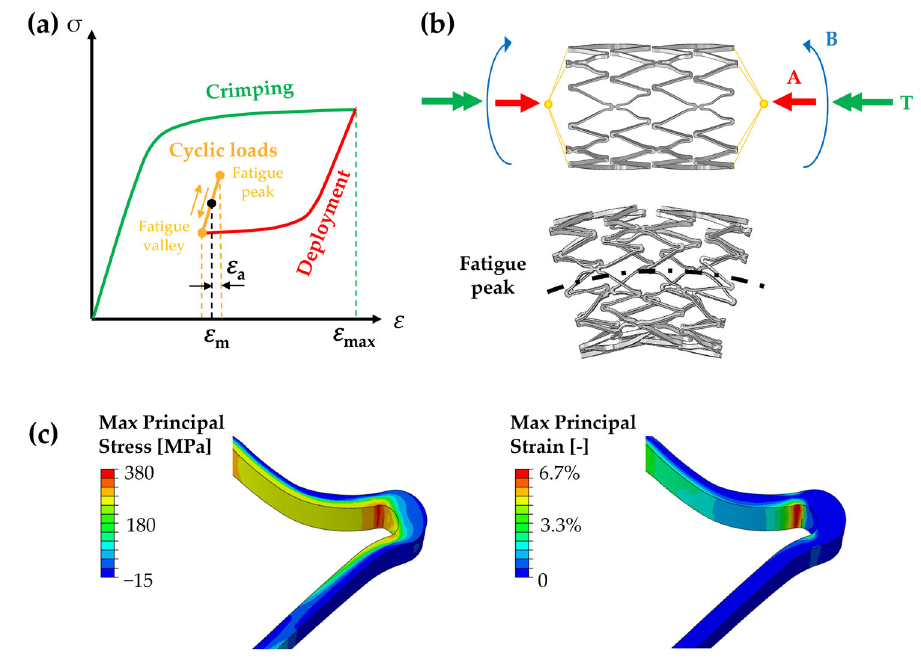
Figure 1. ( a ) Loading sequence of a stent during in vivo implantation and working cycles: the stent reaches a maximum strain, ε max , during the crimping phase, it partially self-expands during the deployment into the stenotic artery, and it undergoes cyclic loads defined by a mean strain, ε m , and a strain amplitude, ε a . ( b ) Schematic representation of the deformation fashion of a peripheral stent under loads representative of an in vivo scenario, including axial compression (A), bending (B), and torsion (T), adapted with permission from [14] (Elsevier, 2023). ( c ) Maximum principal stress and strain distributions in the most-loaded area of the stent at the fatigue peak, showing a gradient in the cross-section.